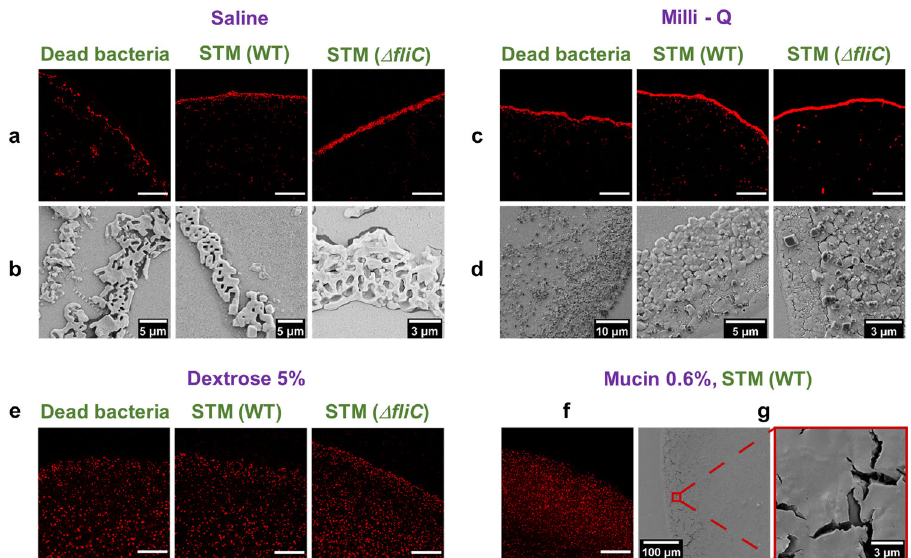
Fig. 3 Bacterial deposition at the edge for four different media. a Confocal (63× magni fi cation) and b SEM images of the deposition at the edge for dead bacteria, STM (WT), and STM ( Δ fl iC ) in saline medium. c Confocal (63× magni fi cation) and d SEM images of the deposition at the edge for dead bacteria, STM (WT), and STM ( Δ fl iC ) in milli-Q medium. e Confocal (63× magni fi cation) images of the deposition at the edge for dead bacteria, STM (WT), and STM ( Δ fl iC ) in dextrose 5wt% medium. f Confocal (63× magni fi cation) and g SEM images of the deposition at the edge for STM (WT) in mucin 0.6wt% medium. Scale bars besides those speci fi ed, 50 μ